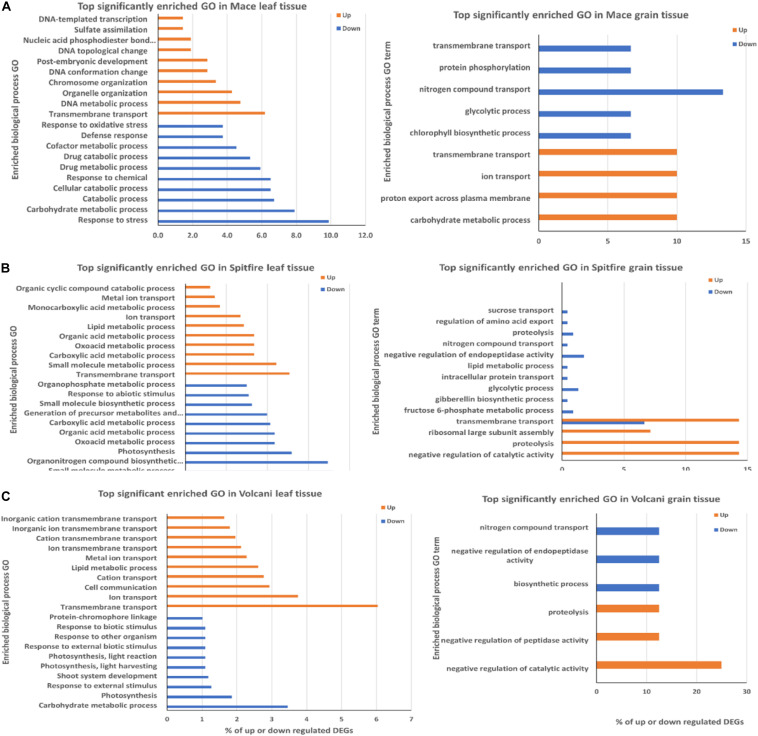
Top biological process GO terms in leaf and grain tissue of wheat cultivars (A) Mace, (B) Spitfire, and (C) Volcani. The frequency of the GO term is shown as percentage of the genes related to the GO term. GO, gene ontology.